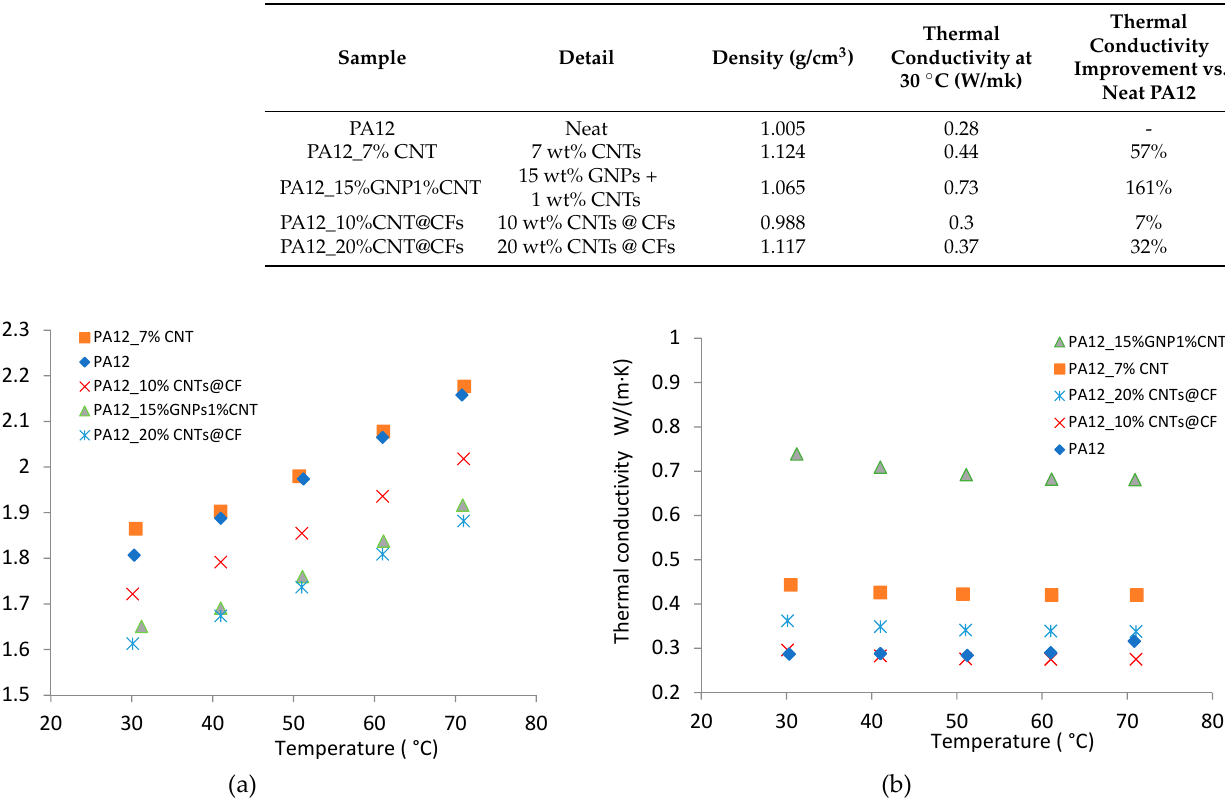
Figure 11. Thermal conductivity of PA12 incorporated with different reinforcements: ( a ) specific heat and ( b ) calculated thermal conductivity. Table 3. Summary of PA12 compounds modified by different filaments.